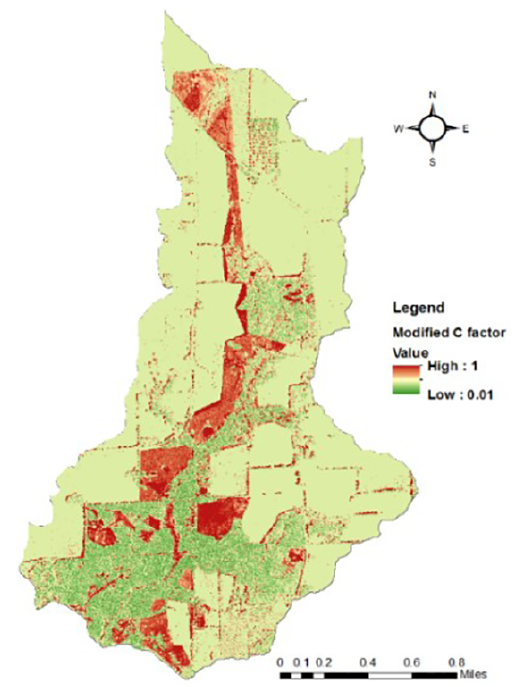
Figure 6. The C Factor Raster Grid of the Soapstone Branch Catch- ment in 2015.